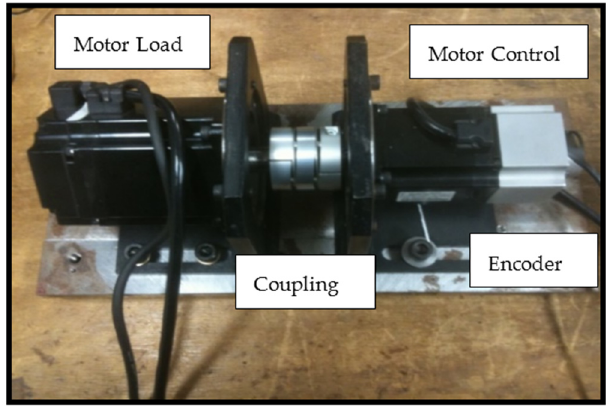
Figure 6. Experimental apparatus.